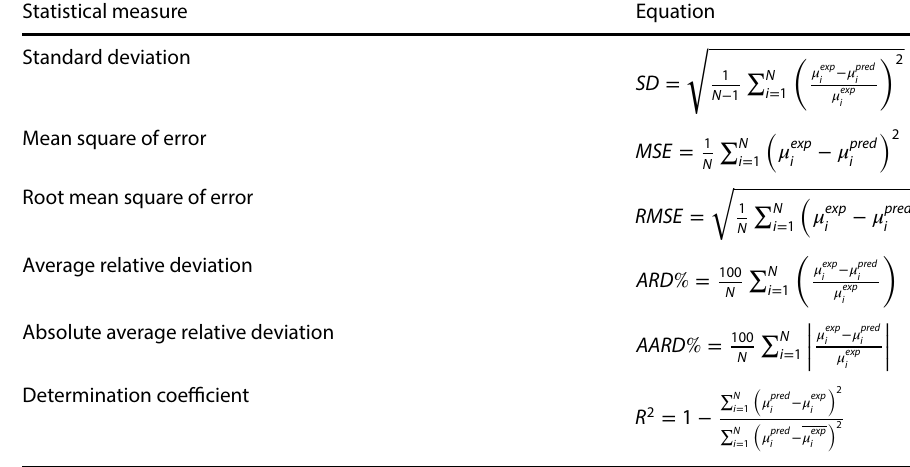
Table 3 The mathematical expressions of the statistical error functions used in this study